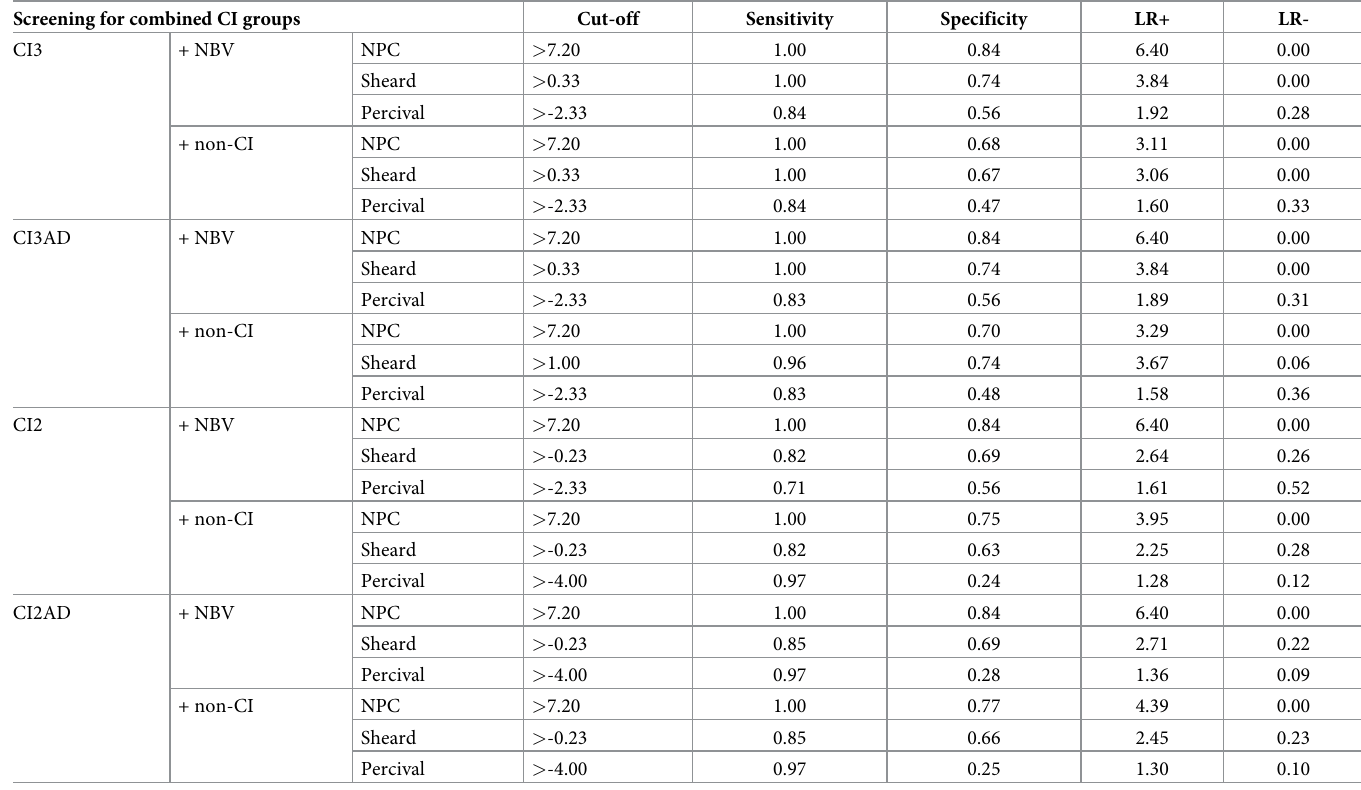
Table 5. Diagnostic validity of NPC and Sheard’s and Percival’s criterion by using cut-offs derived from ROC curve analysis. Screening for combined CI